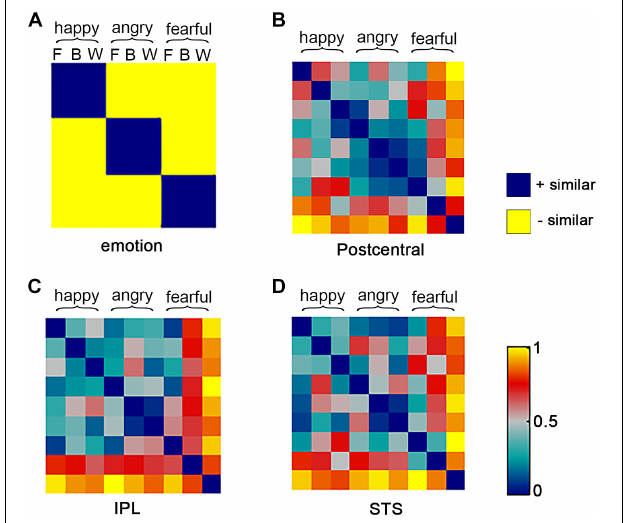
FIGURE 3 | Representational similarity analysis model and neural representational dissimilarity matrices (RDMs). For one abstract emotion model (A) and three neural representation of three clusters (B–D) , the representational dissimilarity matrices were calculated. The model is indexed at two levels in the order in which experimental conditions are rearranged: emotion (happy, angry, and fearful) and stimulus category (F: face B: body W: whole-person). The model dissimilarity matrix illustrates hypothetical correlations of different activity pattern, for example, significant similarity between pair of conditions that from the same emotion (happy–happy pair or angry–angry pair or fearful–fearful pair) should be observed in the abstract emotion model. The neural RDMs illustrate the actual representation of these three brain